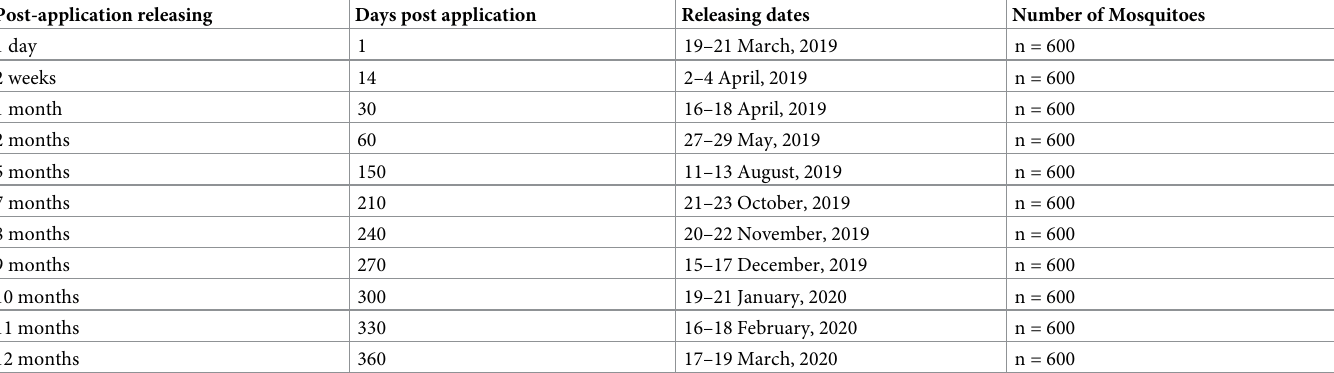
Table 1. Sampling dates for Release of Mosquitoes into experimental houses in Ciudad Caucel neighborhood of Merida, MX. For each of the two experimental houses, three consecutive releasing events were implemented in each period of time to evaluate, using days as replicates (also see Fig 2). The mosquito strain (Juan Pablo) was pyrethroid-resistant; resistance was maintained by periodic reseeding of populations with field-collected eggs (see methods).